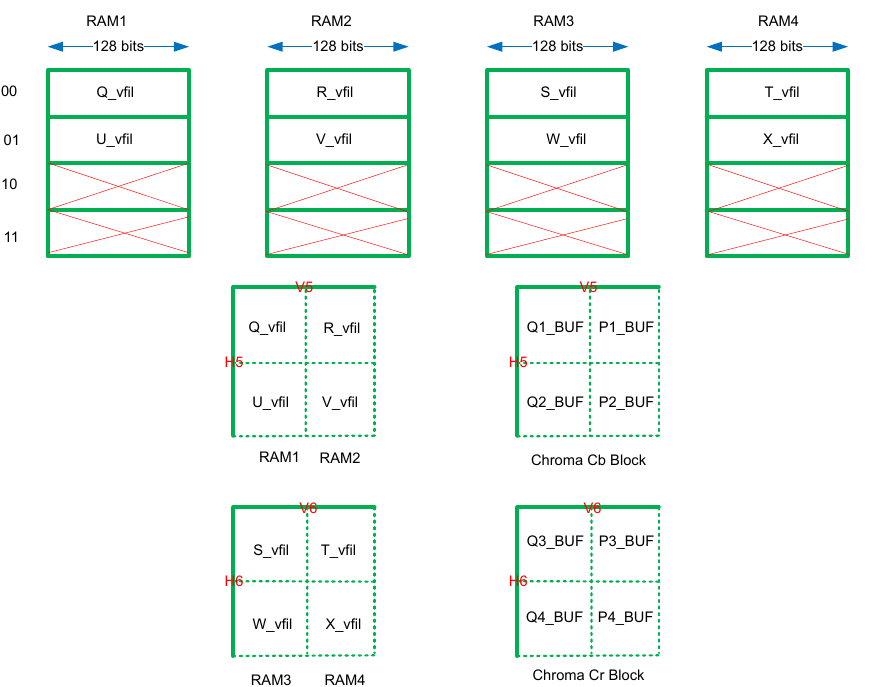
Figure 10. Mapping of internal memory to buffer before horizontal filtering for chroma